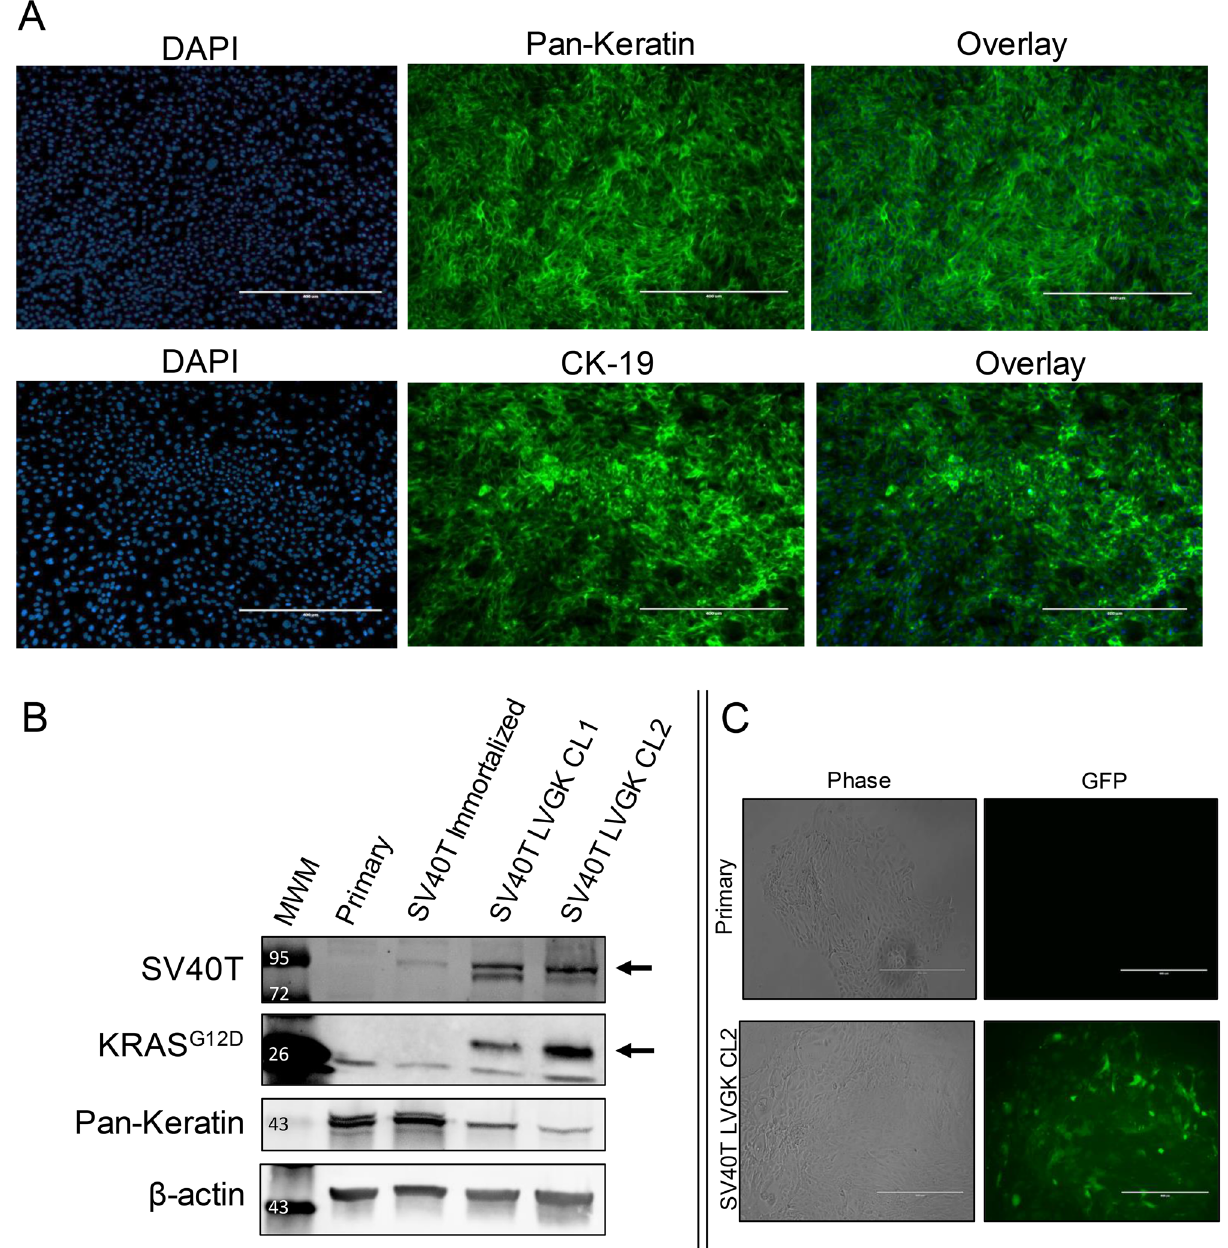
Figure 1. Isolation and transduction of primary porcine pancreatic ductal epithelial cells. ( A ) Immunofluorescent staining for Pan-Keratin and cytokeratin 19 (CK-19) in cultured primary epithelial cells. ( B ) Immunoblot for SV40T, mutant KRAS G12D , and Pan-Keratin in primary epithelial cells, SV40T immortalized cells, and SV40T immortalized cells transformed with KRAS G12D (SV40T LV-GK; two lines, CL1 and CL2) Samples are from the same gel/blot with different IR Dye exposures depending on the secondary for the primary antibody. For full blot images see Fig. S3. Black arrow = band of interest; MWM = molecular weight marker. ( C ) Expression of ZsGreen1 (a green fluorescent protein variant) in primary epithelial cells and SV40T immortalized cells transduced with the LV-GK; phase and inverted fluorescent microscopy of living cells. Measure bars = 400